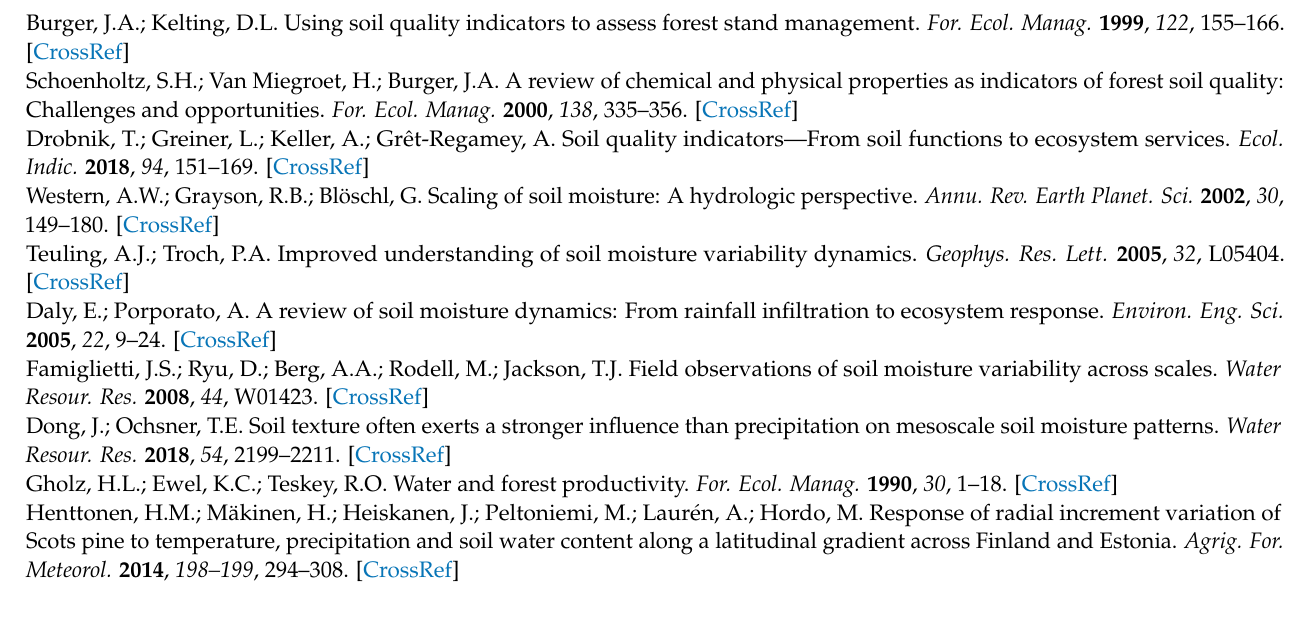
(m 3 m − 3 ), respectively. The lowest row shows topographic wetness (TWI) and depth-to-water index (DTW) and terrain ruggedness index (tri), respectively. The site fertility decreases from herb-rich to xeric; Figure S4: The variability of soil physical and hydrological properties among categories from the most accurate soil maps in Finland. D b (g cm − 3 ) is bulk density, LOI organic matter content (mass %) TP, FC, WP and AWC total porosity, field capacity, wilting point and plant available water (m 3 m − 3 ), respectively. The lowest row shows topographic wetness (TWI) and depth-to-water index (DTW) and terrain ruggedness index (tri), respectively; Figure S5: Inter-annual variability of soil moisture ( θ ) at the driest 5% of grid cells within each site type at Paunulanpuro catchment in Southern Finland. The black lines show 2000–2015 median for given day of year, the dark shade the IQR (25th/75th) and light shade 2.5th/97.5th percentiles. The site-type color is as in Figures 8c and 9. The dashed horizontal lines indicate field capacity and wilting point and their difference plant available water (AWC, Table 2). Note y-axis scale in (a) is different to other panels; Table S1. Examined open geospatial data, their resolution, and